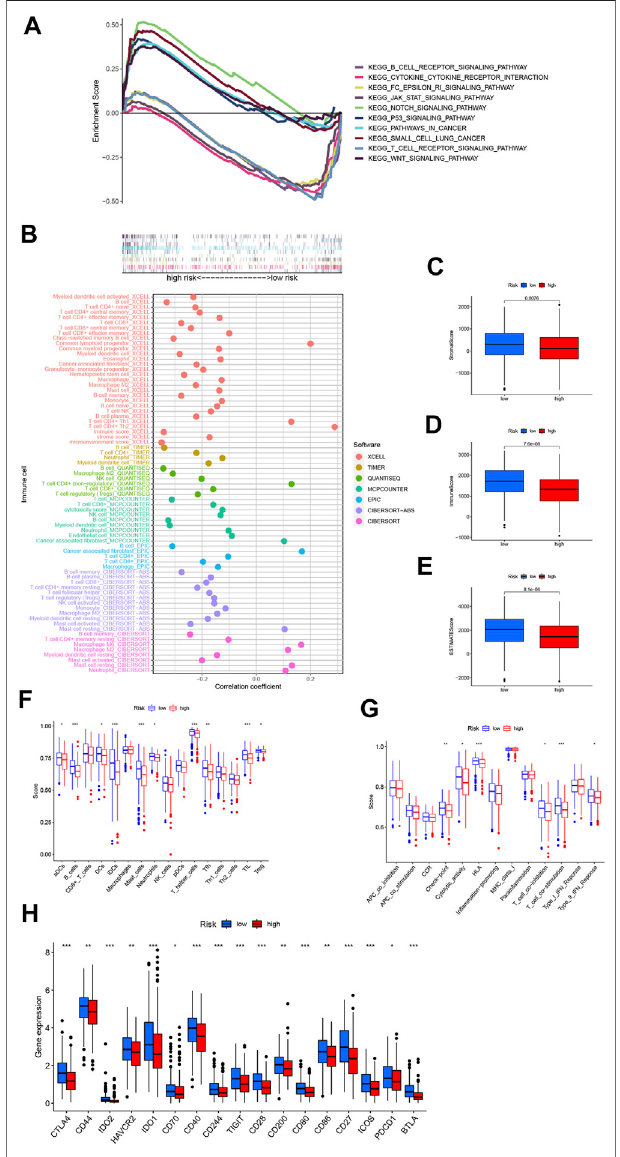
FIGURE 6 | The differences of tumor immune microenvironment between the low- and high-risk groups. (A) Gene set enrichment analysis of the top 10 pathways signi fi cantly enriched in the risk groups. (B) The immune cell bubble of risk groups. (C – E) The box plots of the comparison of StromalScore, ImmuneScore, and ESTIMATEScore, respectively, between low- and high-risk groups. (F, G) The ssGSEA scores of immune cells and immune functions in the risk groups. (H) The difference of common immune checkpoint expression in the risk groups. * p < 0.05, ** p < 0.01, *** p < 0.001.